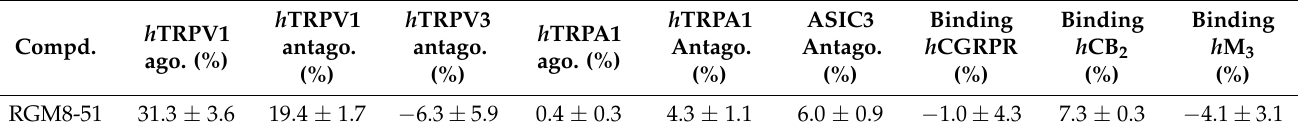
Table 2. Functional activity of RGM8-51 (10 µ M) in Ca 2+ microfluorography assays of TRPV1, TRPV3, TRPA1 and ASIC3 channels, and percentage of inhibition of specific binding at CGRPR, CB2 and M3